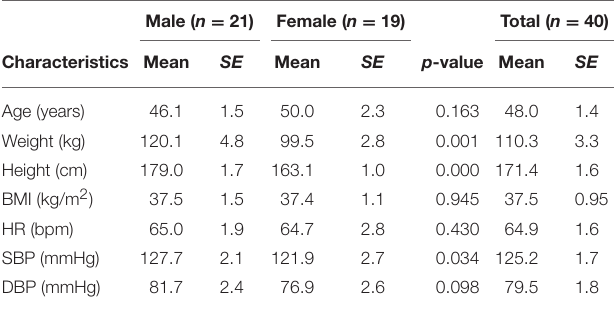
TABLE 3 | Baseline (week 0) characteristics of participants for WL (Phase